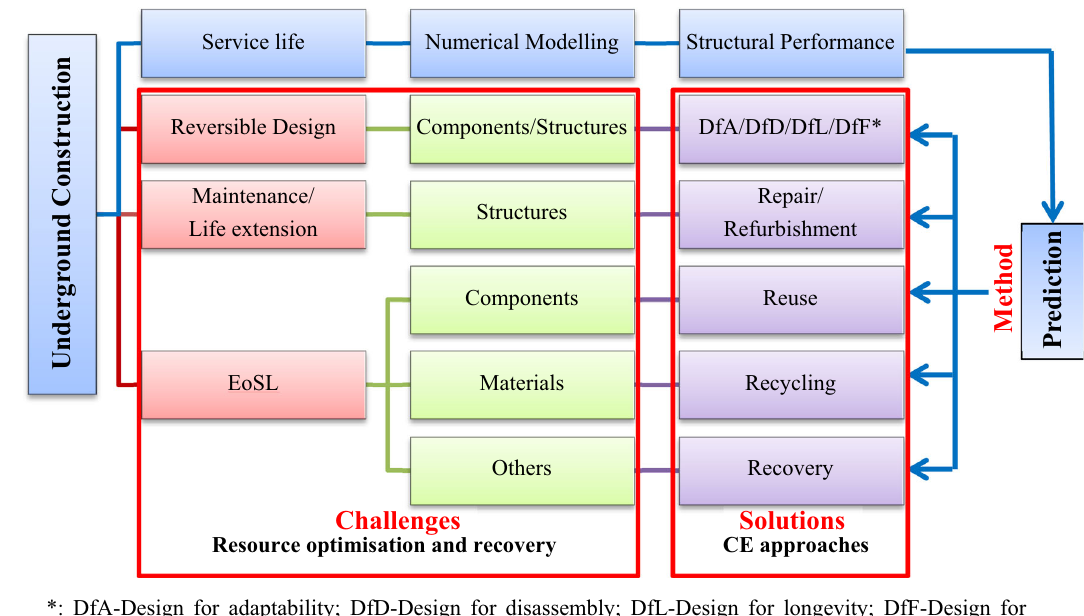
Fig. 1 Methodology for CE solutions in underground